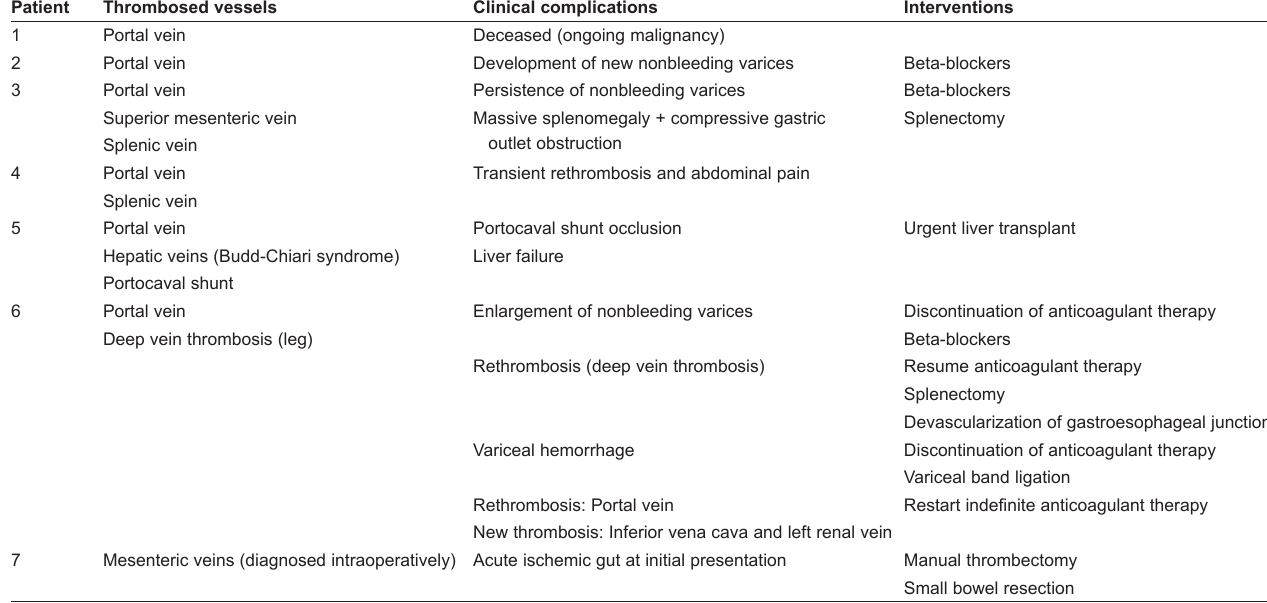
TABle 3 Complications and subsequent interventions in patients failing to achieve clinical